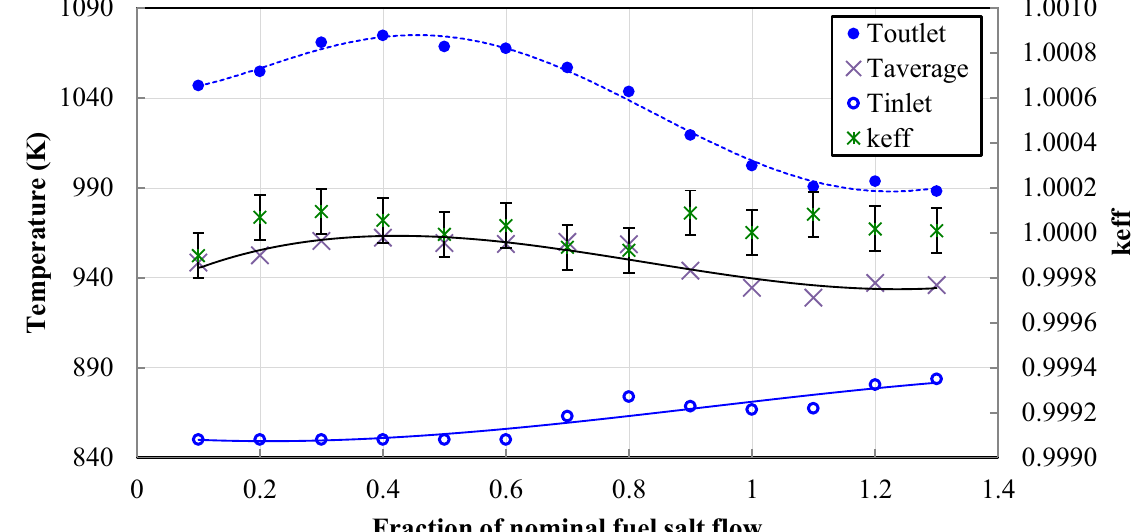
Figure 5.1. Flow rate, outlet temperature and k